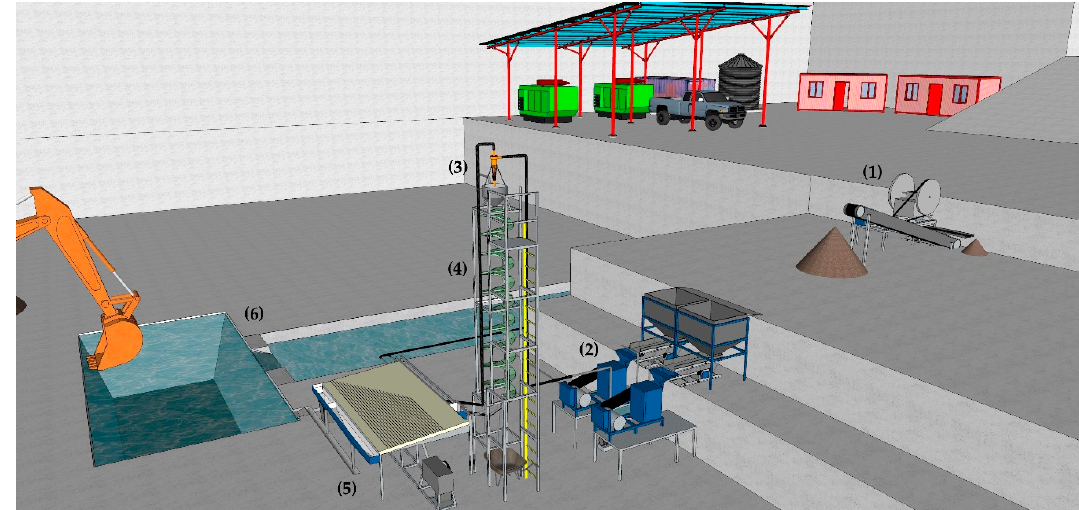
Figure 2. Sketch of the small-scale processing plant for the recovery of lead vanadate minerals. (1) jaw crusher; (2) hammer mill; (3) hydrocyclone; (4) spiral concentrator; (5) shaking table; (6) tailings ponds.